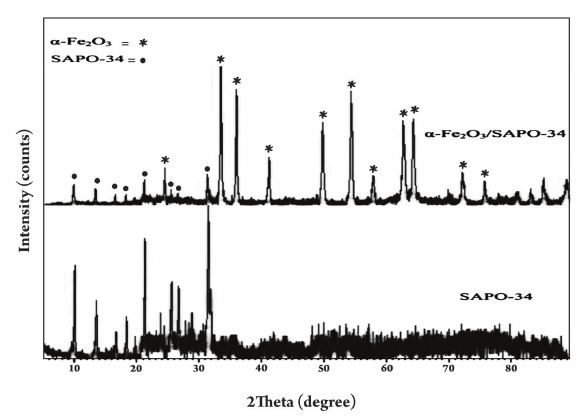
O /SAPO-34 and SAPO-34 as 2 3